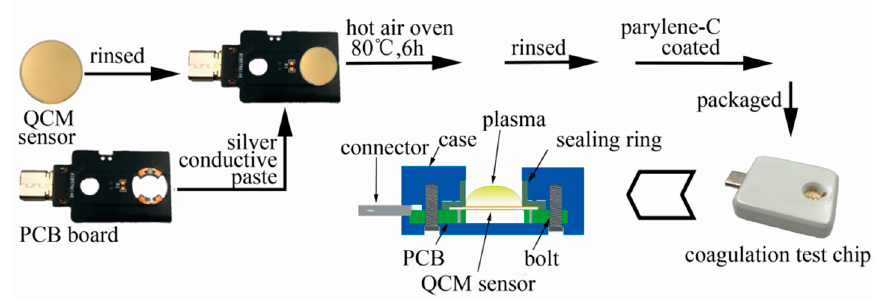
Figure 4. Coagulation test chip design approach.